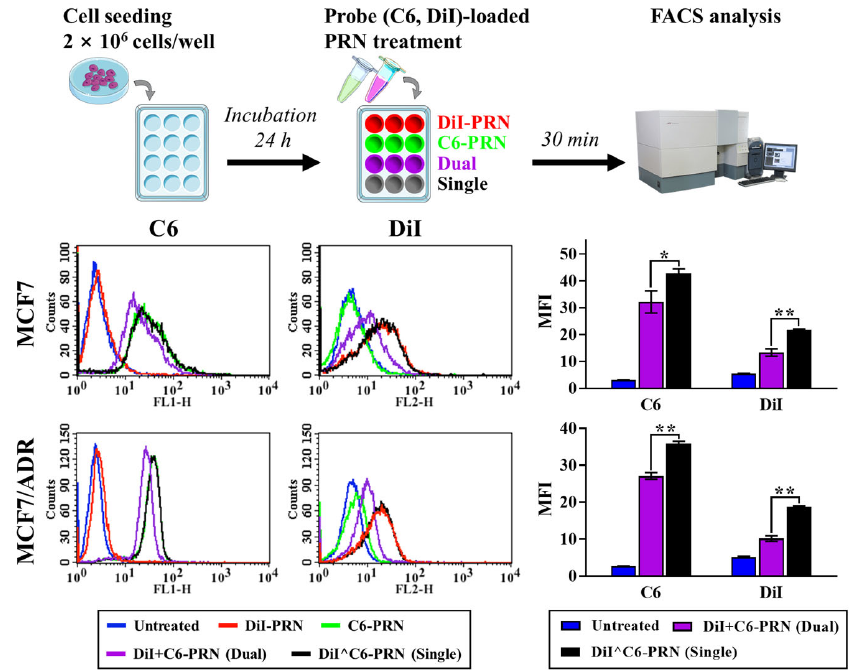
Figure 7. FACS analysis of the competitive cellular uptake for the comparison of the probe ‐ loaded dual ‐ carrier system with the single ‐ carrier system. The cells were incubated for 30 min at 37°C in a medium containing a physically mixed dual ‐ carrier system of 1,1 ′‐ dioctadecyl ‐ 3,3,3 ′ ,3 ′‐ tetramethylindocarbocyanine perchlorate (DiI) ‐ loaded PEGylated (5 mol%) and RIPL peptide ‐ conjugated nanostructured lipid carrier (PRN; DiI ‐ PRN) and coumarin ‐ 6 (C6) ‐ loaded PRN (C6 ‐ PRN) (DiI+C6 ‐ PRN; Dual delivery system) or DiI ‐ and C6 ‐ loaded PRN (DiI^C6 ‐ PRN; Single delivery system) at the following concentrations: DiI: 50 ng/mL; C6: 16.4 ng/mL. Data represent the mean ± standard deviation (SD) ( n = 3). Significant differences were noted at * p < 0.005 and ** p < 0.001.